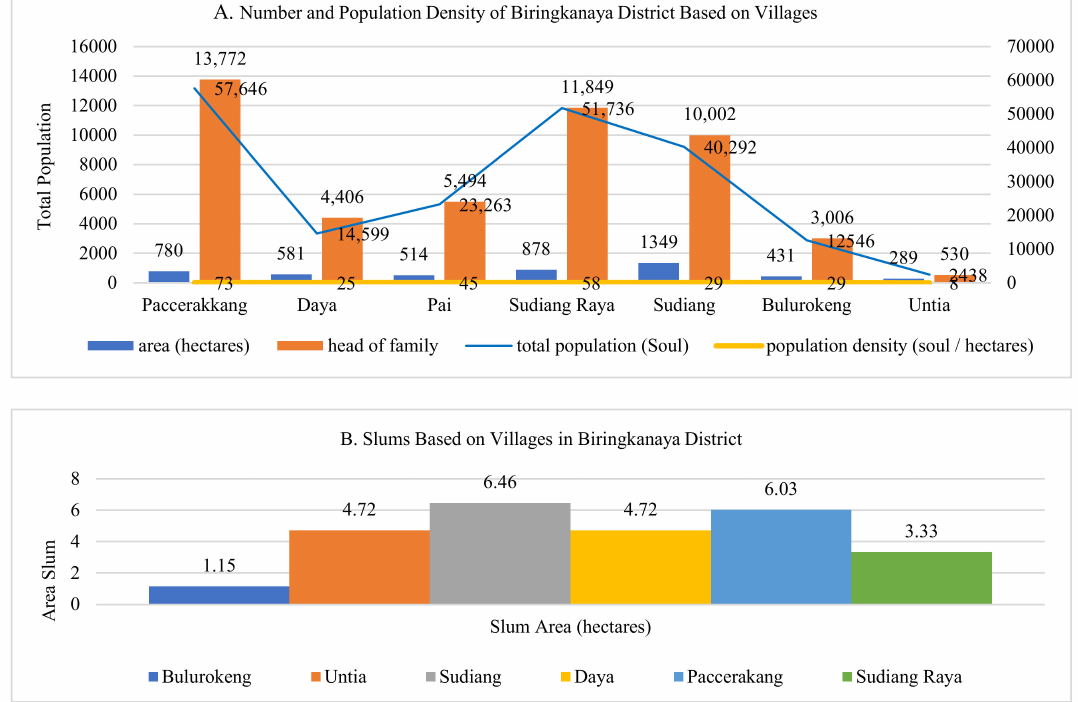
Figure 5. ( A ) Number of slum residents and ( B ) settlements in the Biringkanaya District